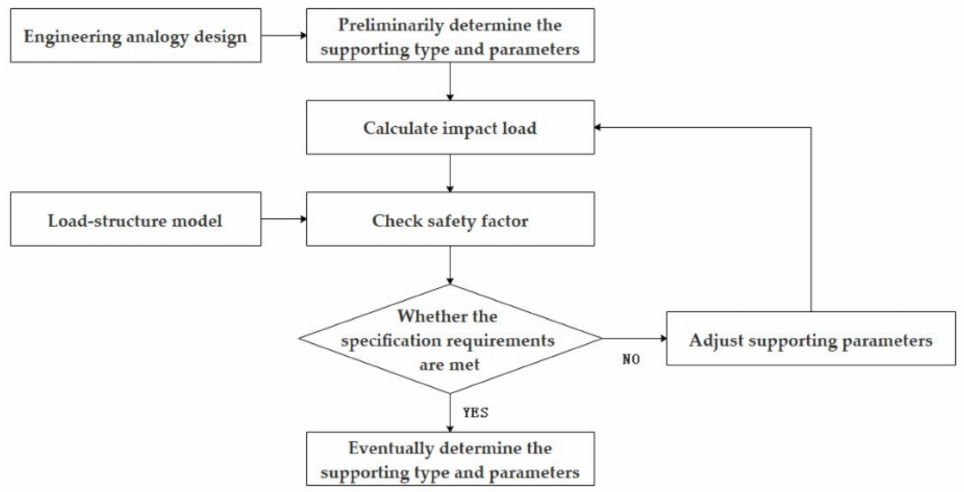
Figure 16. Design